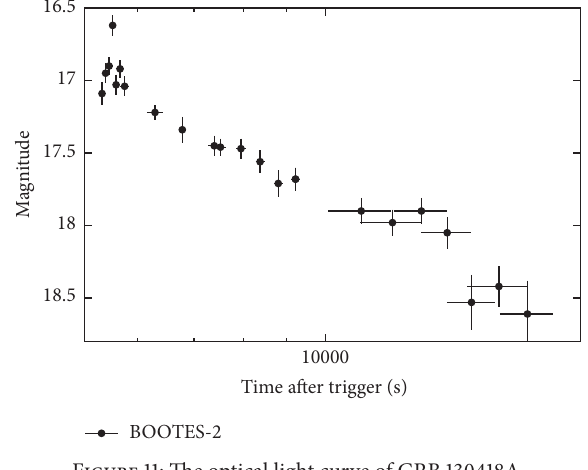
Figure 11: The optical light curve of GRB 130418A.